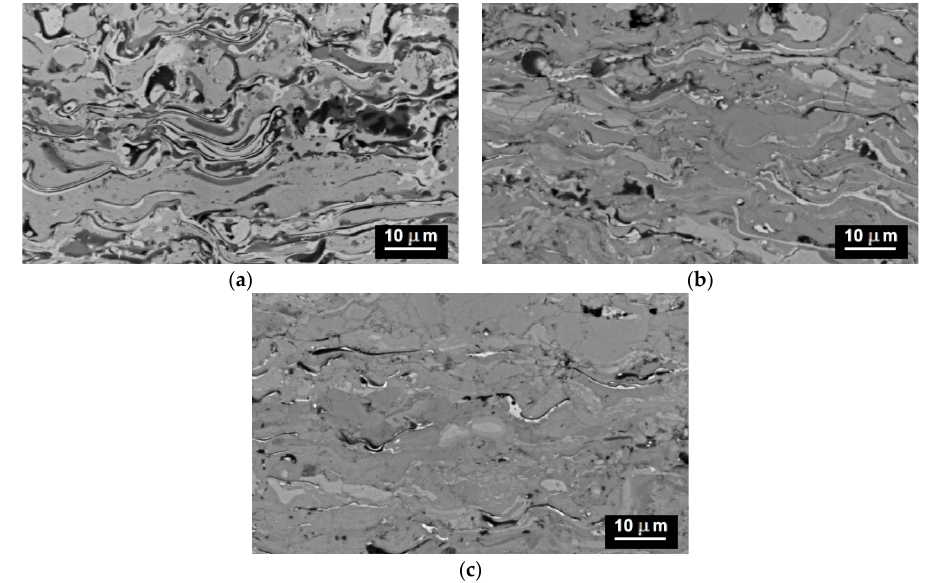
Figure 4. Cross sections of the FeAl coatings obtained with the different powders: ( a ) coating 1, ( b ) coating 2, and ( c ) coating 3.